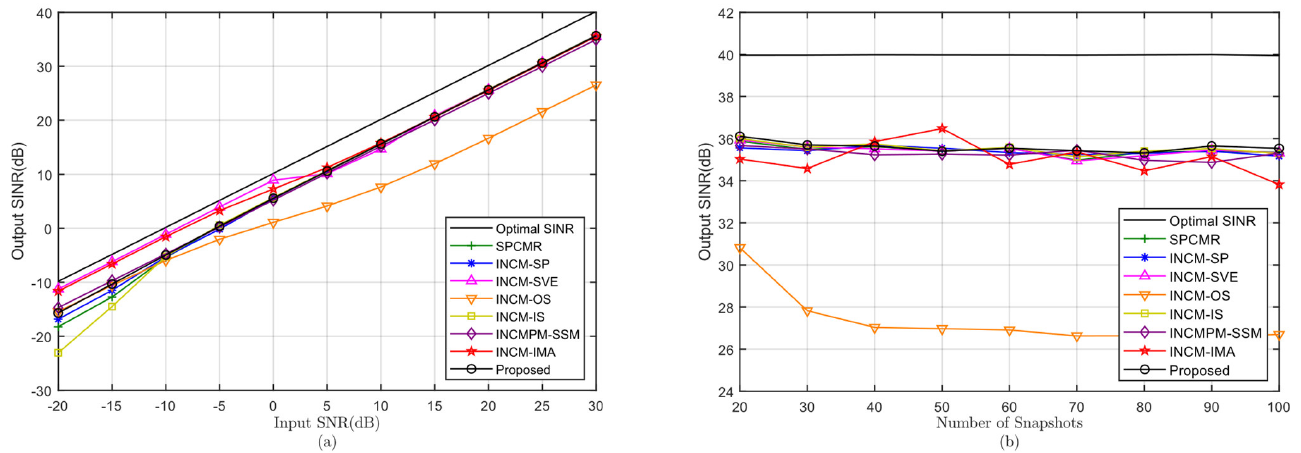
Figure 2. Example 1: output SINR vs.: ( a ) input SNR; ( b ) number of snapshots. Figure - 2. Example 1: output SINR vs.: ( a ) input SNR; ( b ) number of snapshots.